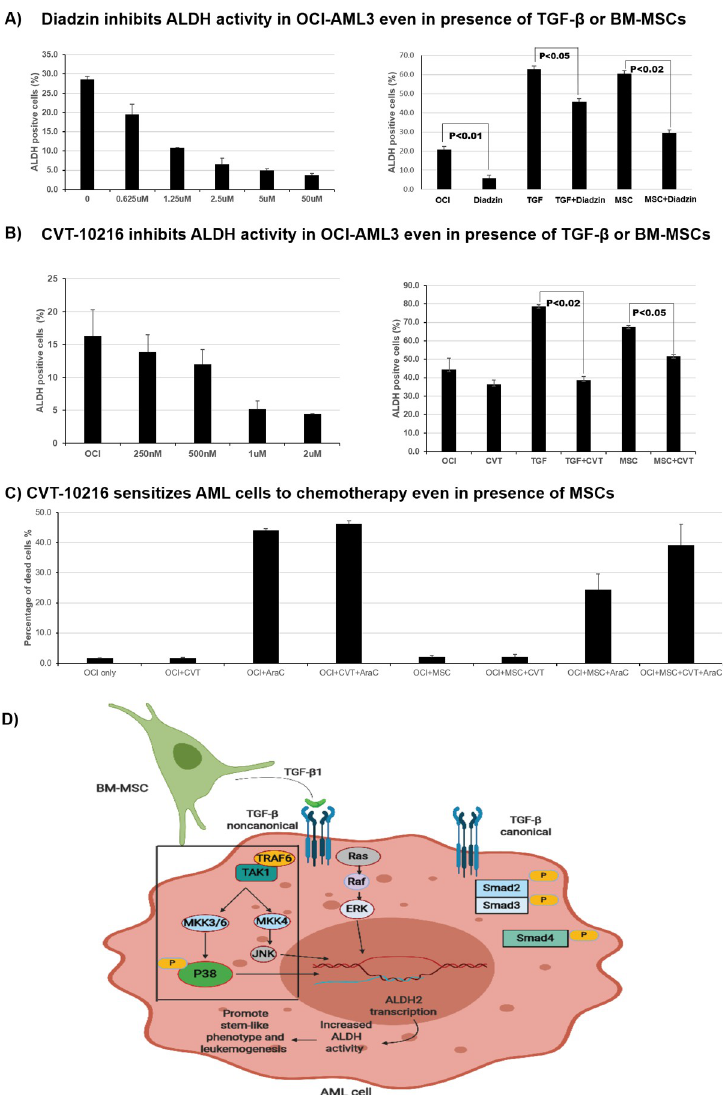
Fig 6. ALDH2 inhibitors decrease stroma-induced ALDH activity in AML cells and sensitize them to chemotherapy. (A) OCI-AML3 cells were cultured and treated with increasing concentrations of the ALDH2 inhibitor diadzin. ALDH activity was measured by ALDEFLUOR 1 assay using flow cytometry. OCI-AML3 cells were co-cultured with MSCs (200 000 cells/well density) and treated with diadzin (5 μ M) for 3 days in the presence or absence of recombinant TGF- β 1 (5 ng/mL). ALDH activity was measured as described above. (B) The same experiments were performed as in A , using CVT-10216 (at increasing concentrations and 1 μ M) instead of diadzin. (C) OCI-AML3 cells were cultured alone or with MSCs (100 000 cells/well density) and treated with cytarabine (2.5 μ M) alone or in combination with CVT-10216 (2 μ M) for 48 hours. Cell samples were stained with Annexin V and analyzed by flow cytometry to measure treatment-induced cell death. Data are plotted as mean values with error bars representing standard error. (D) Simplified schematic representation of the interaction between stromal cells and AML cells leading to ALDH2 expression. BM-MSCs secrete TGF- β 1, which induces ALDH2 expression in AML cells through the non-canonical/p38-dependent pathway, thereby promoting leukemogenesis. For A , B , and C one-way ANOVA with Tukey’s HSD post-hoc test was used (N =